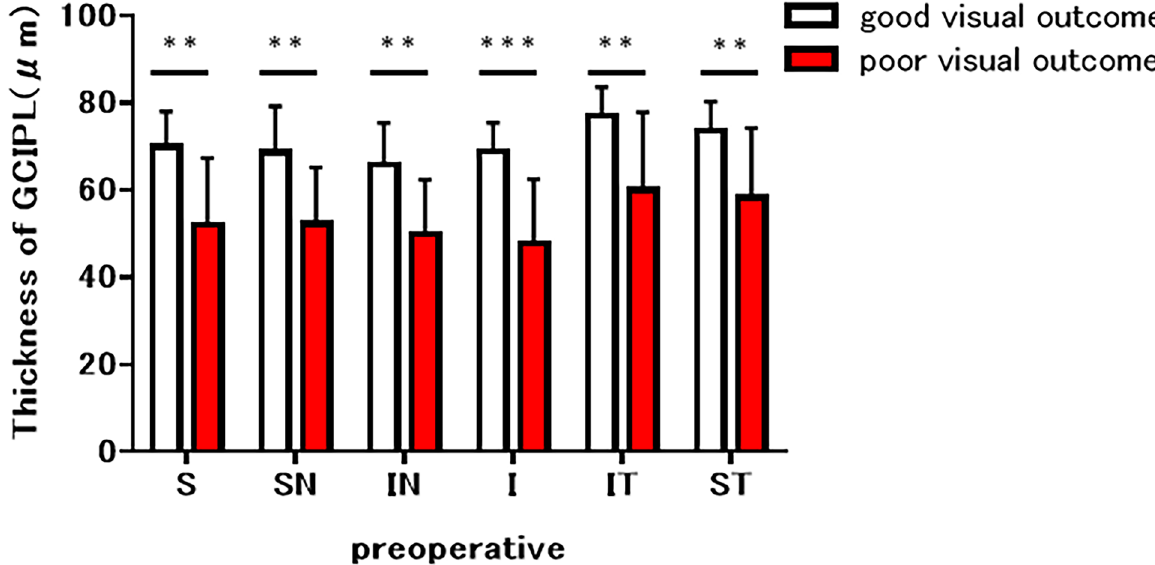
Figure 4. Comparison of preoperative ganglion cell layer (GCL) + inner plexiform layer (IPL) thickness between eyes with and without postoperative visual disturbance in eyes with optic nerve bending. Graphs showed the superior (S), superior nasal (SN), inferior nasal (IN), inferior (I), inferior temporal (IT), and superior temporal (ST) sectors of the macular, respectively. Preoperative GCL + IPL thickness was lesser in eyes with postoperative visual disturbance than in eyes with postoperative non-visual disturbance in all sectors (***p < 0.001, inferior sector; **p < 0.01, other 5 on MR images before tumor resection, as previously reported 4 . Briefly, the ONCBA is the angle obtained by neu- rosurgeons measuring the extent of this bending on sagittal MR images formed by the optic nerve in the optic canal and the optic nerve in the intracranial subarachnoid space at the entrance of the optic canal. Each neuro- surgeon specializing in pituitary tumor MR reading and surgery (R.Y. and M.T.) made evaluations, and any disa- greements regarding conclusions were resolved by consensus. Optic nerve bending (large ONCBA) was defined as ONCBA ≥ 45°, and non-optic nerve bending (moderate ONCBA) was defined as ONCBA < 45°, as previously reported 4 . The exclusion criteria were as follows: (1) patients with a history of glaucoma or evident glaucomatous optic neuropathy; (2) high myopia (refractive error less than − 6 diopters); (3) retinal diseases, including epireti- nal membrane and macular edema; (4) severe cataract, and (5) unclear optic nerve on MR imaging. All patients underwent ophthalmologic examinations, including best-corrected visual acuity (BCVA), intraoc- ular pressure assessment, refraction, slit-lamp biomicroscopy, fundus examination, and GCL + IPL thickness measurement, using Cirrus high definition-OCT (Carl Zeiss Meditec, Dublin, CA, USA) in both the optic nerve bending and non-bending eyes before and 1 month after tumor resection (Fig. 7). BCVA was recorded as the decimal visual acuity and converted to logarithm of the minimum angle of resolution (logMAR) notation. The Cirrus HD-OCT ganglion cell analysis (GCA) algorithm automatically segmented the macula into superior, superior nasal, inferior nasal, inferior, inferior temporal, and superior temporal sectors, and measured the GCL + IPL thickness 5 . Statistical analyses. Data are presented as the mean ± standard deviation. An unpaired t-test was con- ducted to compare BCVA and GCL + IPL thickness measurements between the bending and non-bending eyes. The paired t-test was conducted to compare changes in BCVA and GCL + IPL thickness before and 1 month after surgery. The correction between BCVA and ONCBA was examined using Spearman’s correlation coefficient. Statistical significance was set at p < 0.05. Statistical analyses were performed using GraphPad Prism version 6 (GraphPad Software Inc., La Jolla, CA, USA).